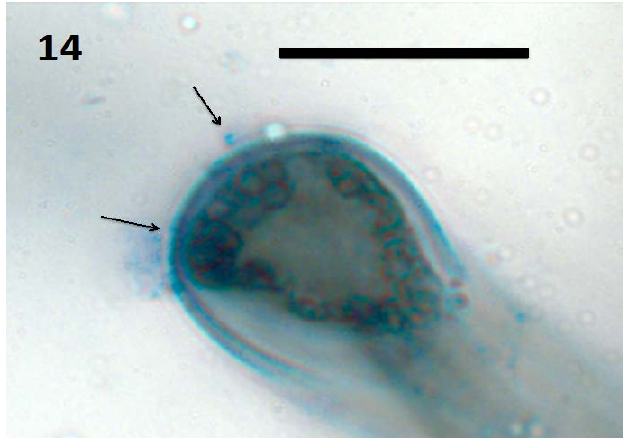
Figure 14. Tomato seedling root hair tip showing spherical L-forms of bacteria (arrows; bar = 20 µm; stained with 3,3-diaminobenzidine followed by aniline blue).